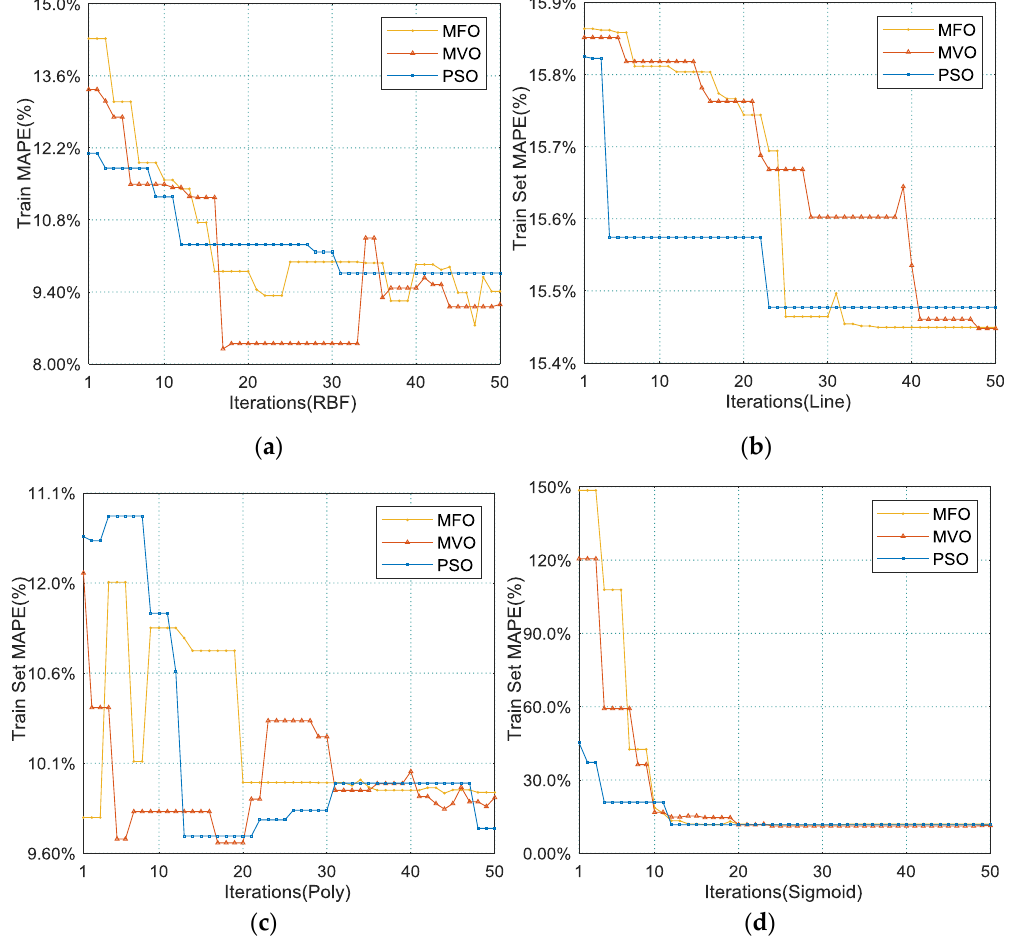
Figure 4. The mean absolute percentage error (MAPE) curve of the training set. ( a ) Gaussian, ( b ) linear, ( c ) polynomial, ( d ) sigmoid.